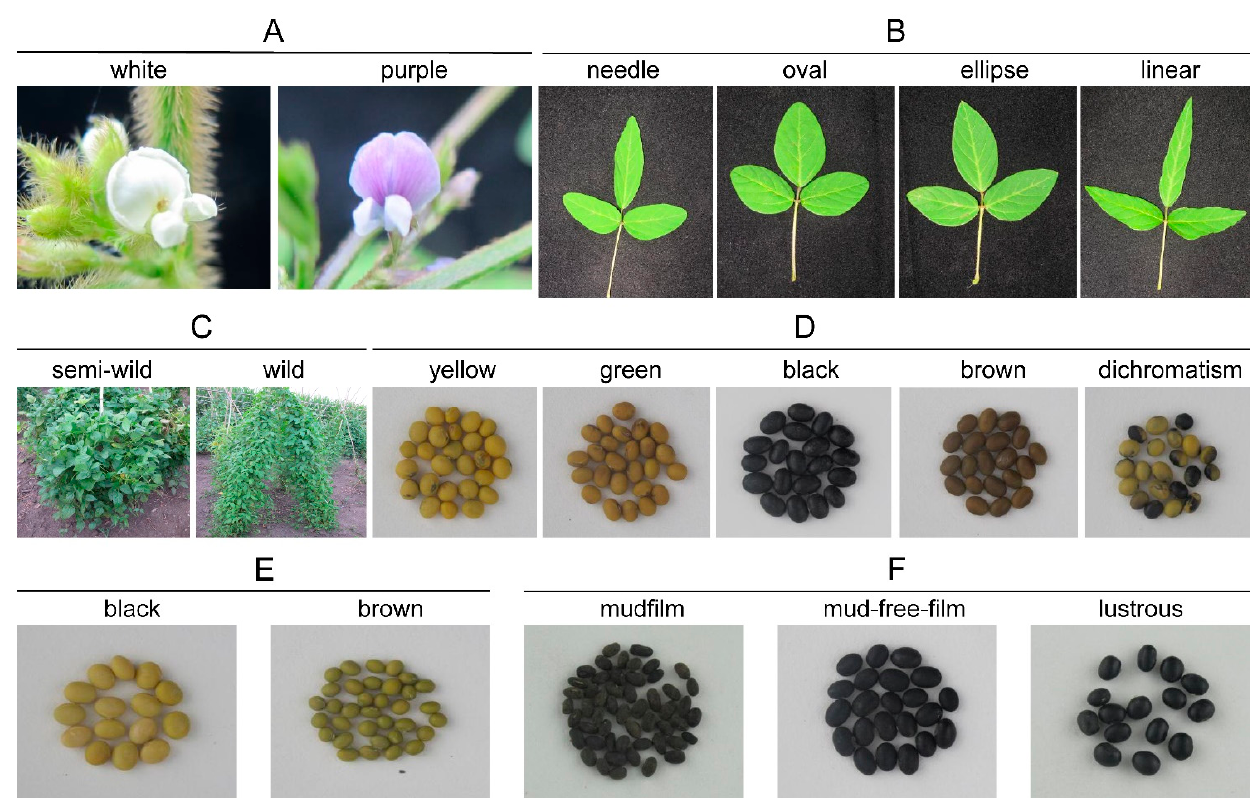
Figure 2. Qualitative traits, namely flower color ( A ), leaf shape ( B ), evolutionary type ( C ), seed color ( D ), hilum color ( E ), and bloom habit ( F ), investigated for 242 wild soybean samples in this study.